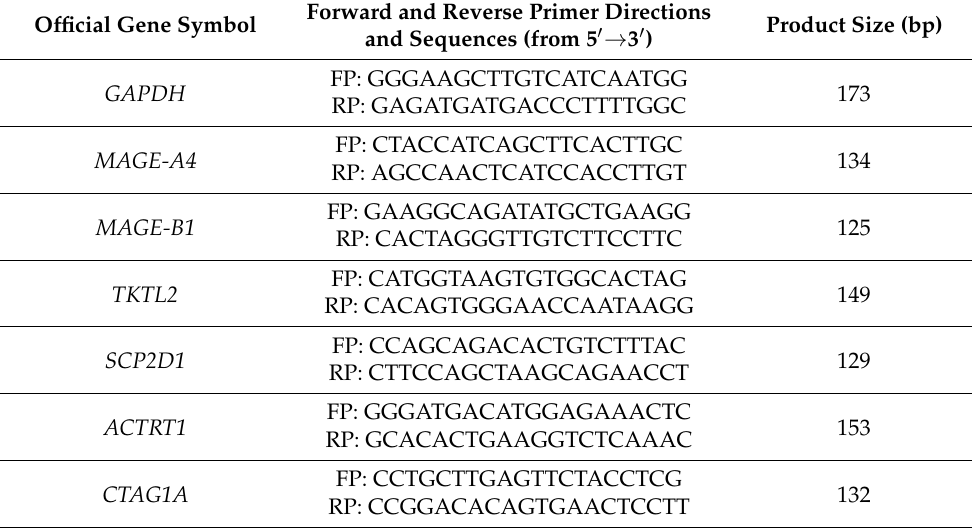
Table 2. Sequences of the primers used in the qRT-PCR and their estimated product sizes. Official Gene